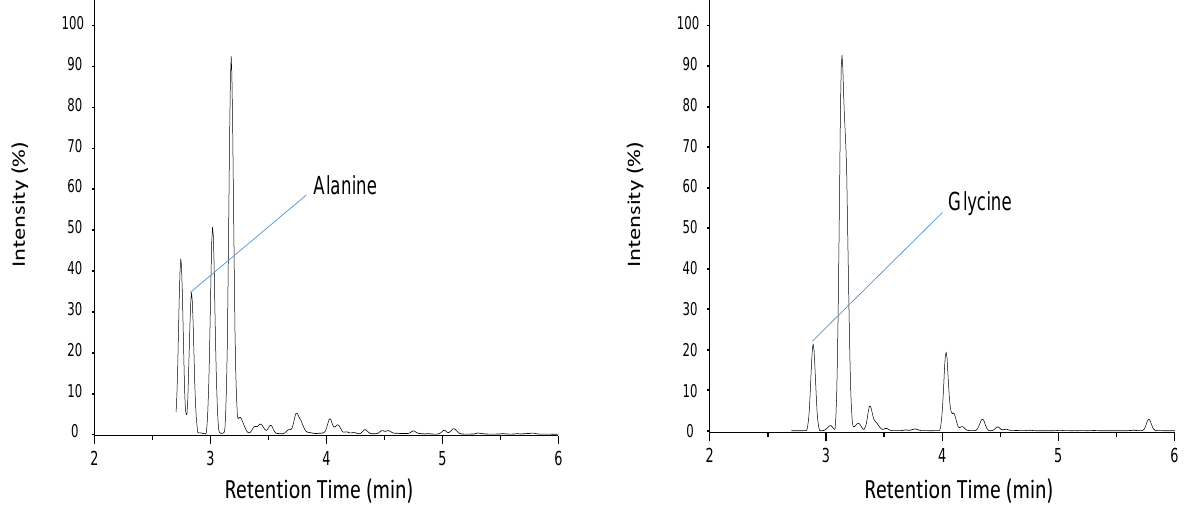
Figure 5. Mass fragmentograms of two compounds: alanine and glycine extracted from peak 1 at 2.87 min using specific mass fragments ( m/z 158 and m/z 218, respectively).